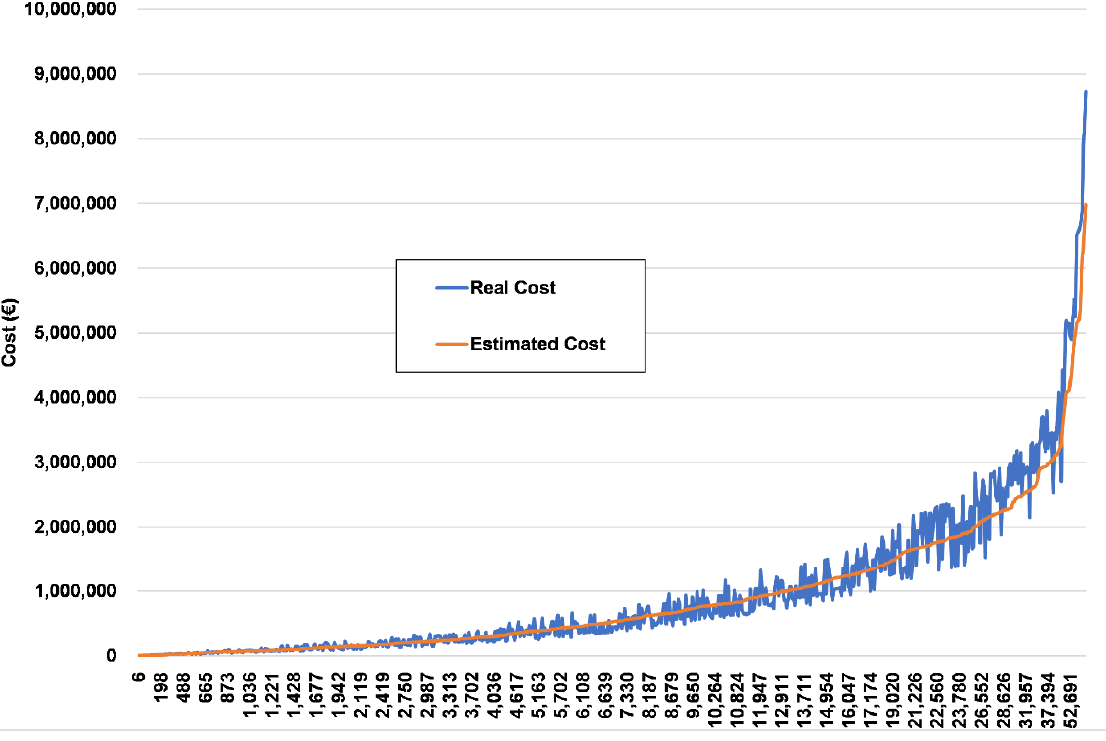
Figure 15. Real Costs and expected costs using the function estimated